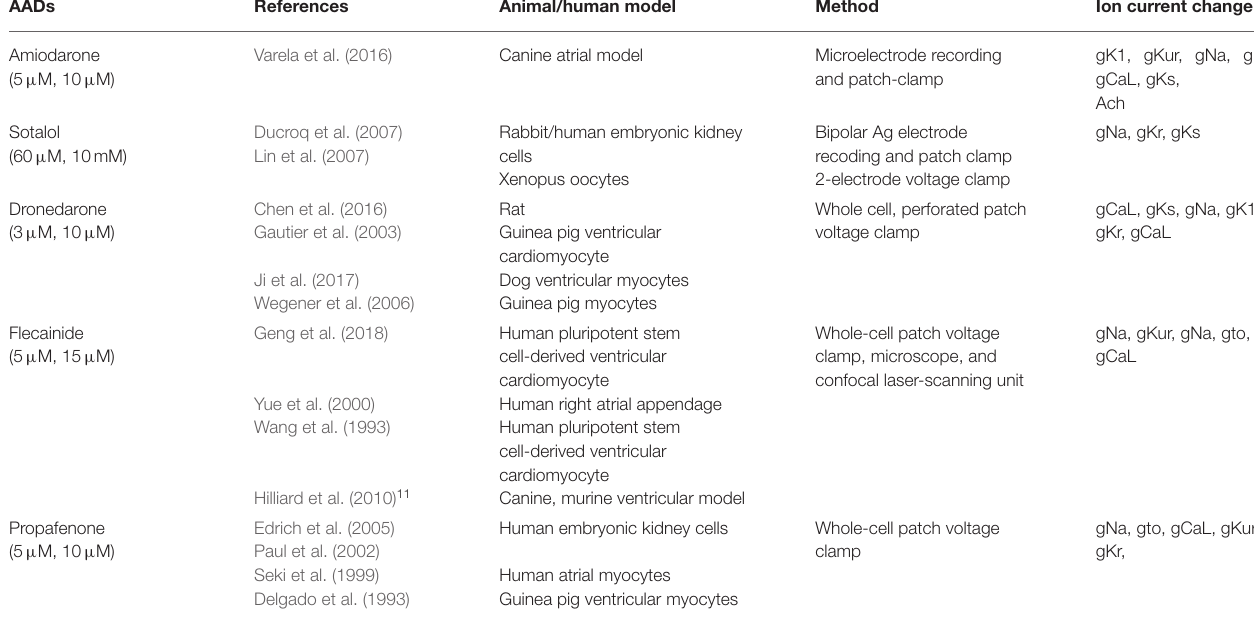
TABLE 2 | References for atrial cell ion currents depending on AADs.